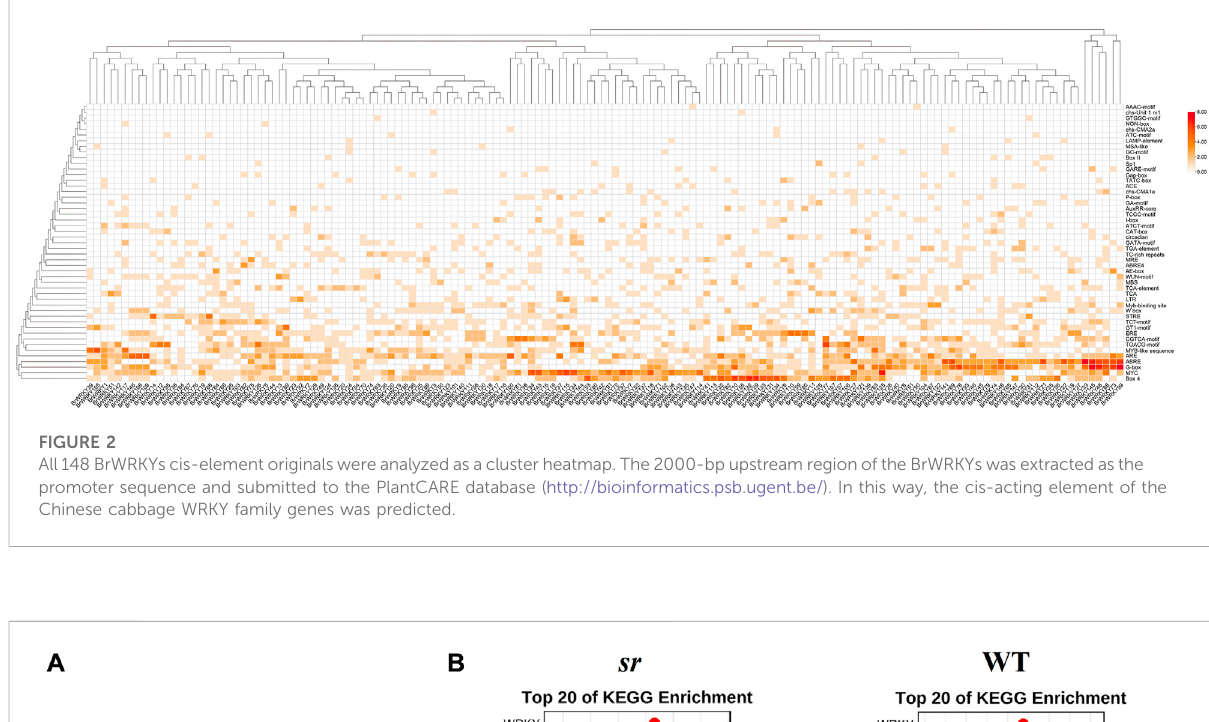
FIGURE 2 All148 BrWRKYs cis-element originals wereanalyzed as acluster heatmap.The 2000-bp upstream regionoftheBrWRKYs wasextracted asthe promoter sequence and submitted to the PlantCARE database (http://bioinformatics.psb.ugent.be/). In this way, the cis-acting element of the Chinese cabbage WRKY family genes was predicted.